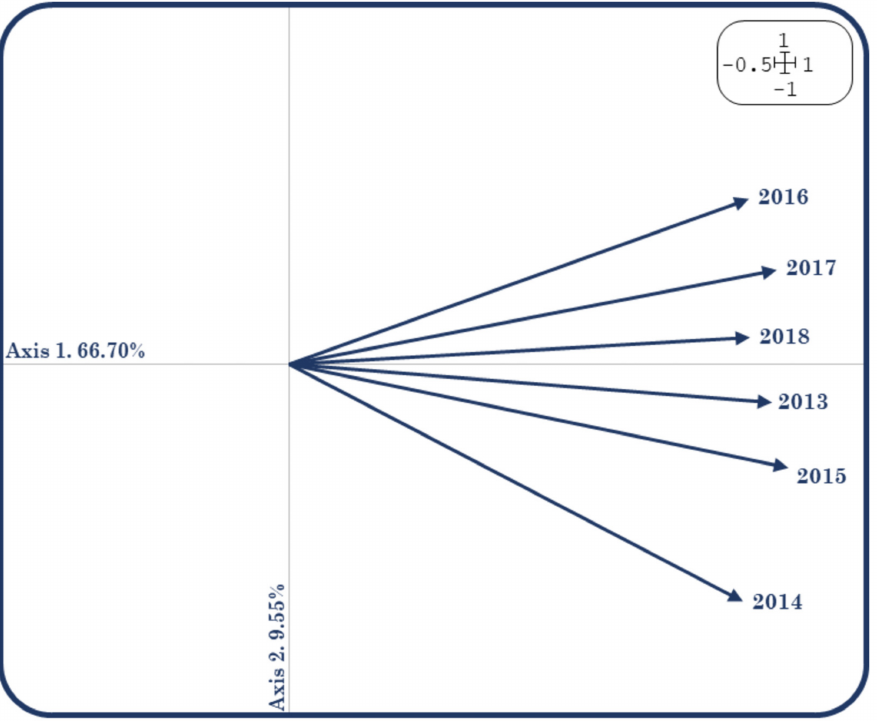
Figure 3. Representation of the X-STATIS interstructural analysis by year.